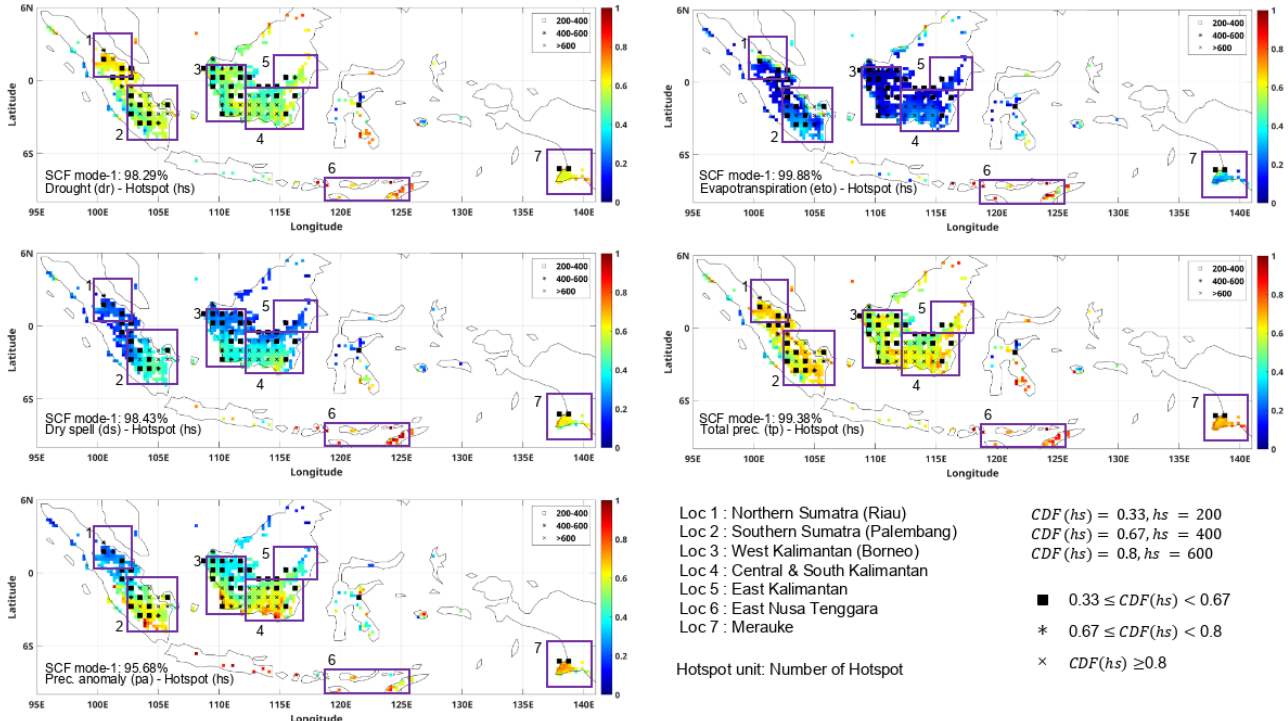
Figure 5. Joint spatial pattern of hotspots paired with drought indicators.